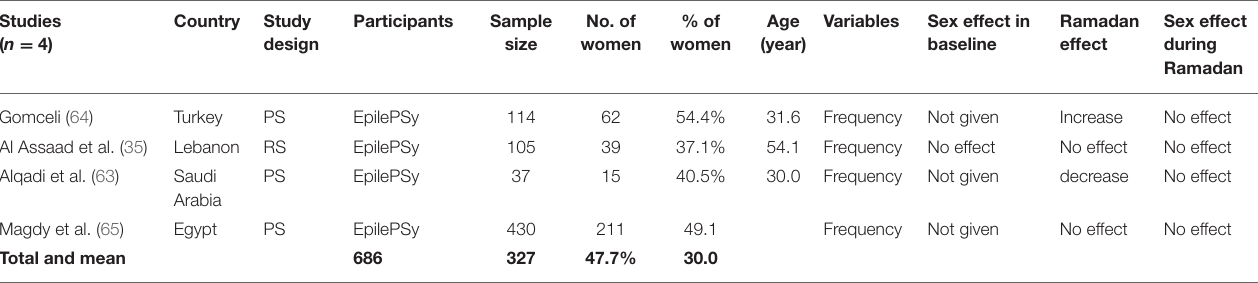
TABLE 8 | Sex differences in the frequencies of epilepsy in patients during and outside the month of